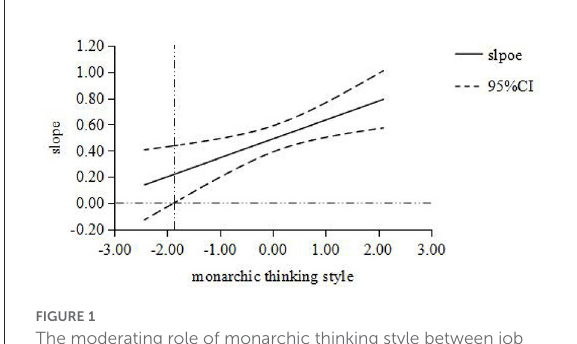
FIGURE3 The moderating role of external thinking style between job stress and PTSD. The abscissa is the moderating variable of external thinking style, and the ordinate represents the change of regression coefficient (i.e., slope) in regression equation with PTSD as dependent variable, job stress as independent variable and external thinking style as moderating variable. All variables are standardized; The middle line is the point estimate, and the upper and lower lines are the values of 95% confidence